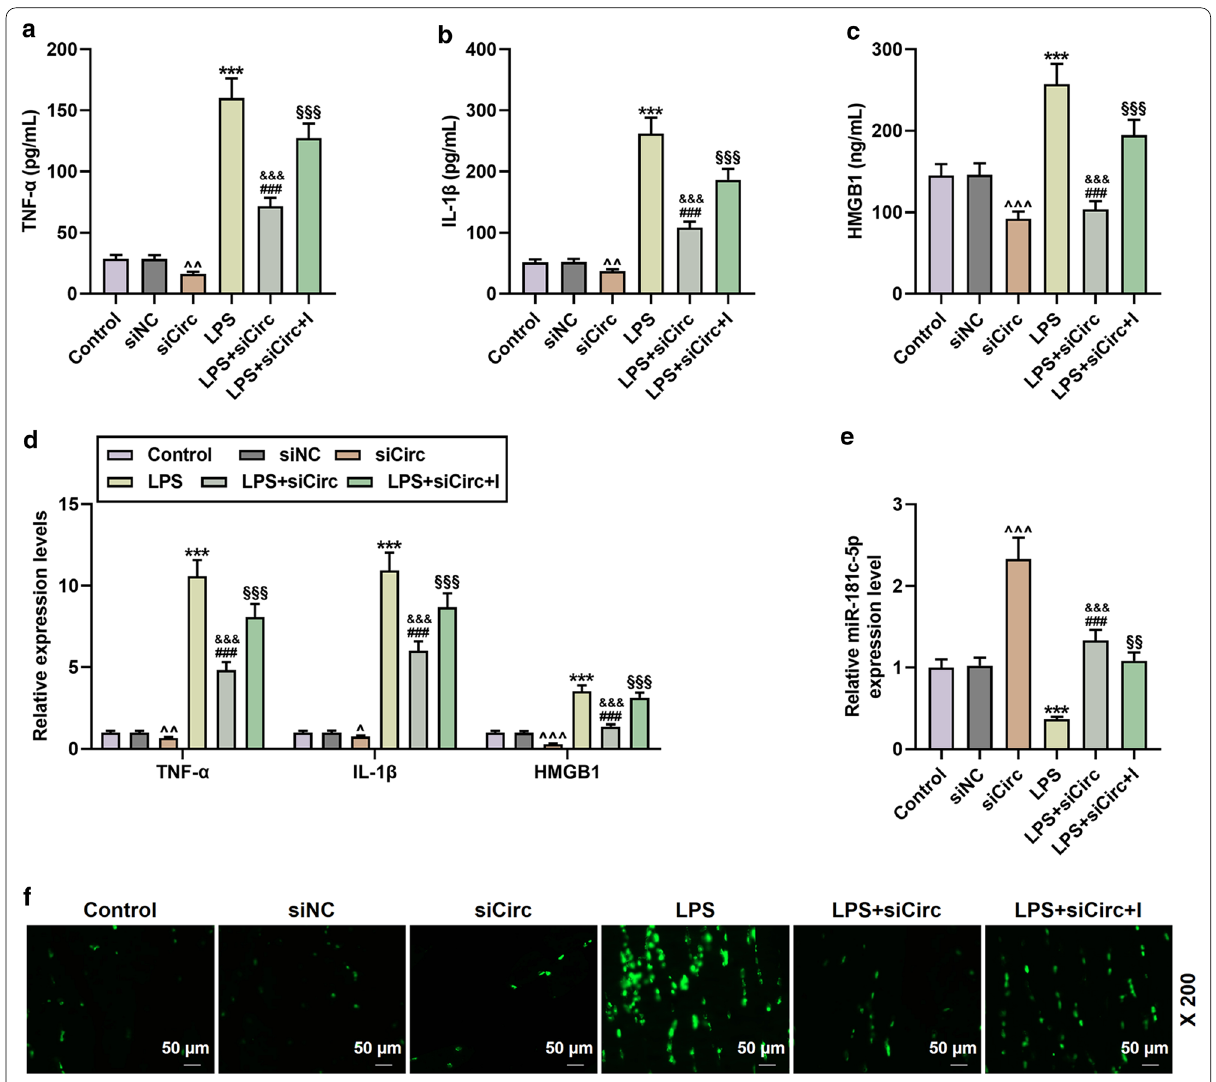
Fig. 6 CircPTK2 partially offset the effect of miR-181c-5p on cytokines and apoptosis in microglia. a – d The contents and mRNA levels of TNF-α, IL-1β, and HMGB1 in the Control, siNC, sicirc, LPS, LPS *** P < 0.001 vs. Control; ^^ P < 0.01, ^^^ P < 0.001 vs. siNC; &&& P < 0.001 vs. siCirc; ### P < 0.001 vs. LPS; §§§ P < 0.001 vs. LPS followed by Bonferroni’s post-hoc test. e QRT-PCR was used to determine the level of miR-181c-5p in each group. N *** P < 0.001 vs. Control; ^^ P < 0.01, ^^^ P < 0.001 vs. siNC; &&& P < 0.001 vs. siCirc; ### P < 0.001 vs. LPS; §§ P < 0.01 vs. LPS followed by Bonferroni’s post-hoc test. f The apoptosis of microglia in each group was detected by TUNEL. Sicirc sicircPTK2; ELISA enzyme linked immunosorbent assay; qRT-PCR quantitative reverse transcription real time polymerase chain reaction. β-actin or U6 were used as control (See figure on next page.) Fig. 7 Effects of circPTK2 and miR-181c-5p on learning and memory functions, mitochondrial function, hippocampal cell apoptosis and